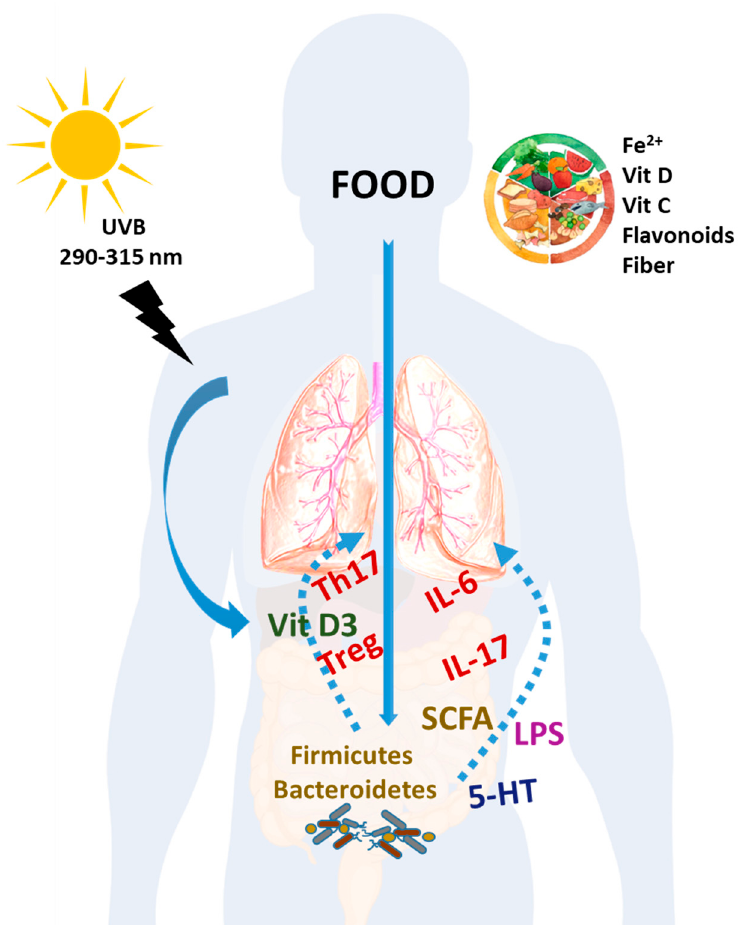
Figure 1. Impact of nutrition in PAH. Dietary components such as Fe 2+ , vitamins C and D, flavonoids and other related polyphenols, and fiber as well as vitamin D obtained from the exposure to sunlight may have a positive impact the quality of life and prognosis of PAH patients. Each dietary factor may have its own mechanism of action. However, part of the effects of these nutrients may be related to their effect on the immune system with restoration of T cells and cytokines, changes in the microbiota and their bacterial products, and bacterial translocation.